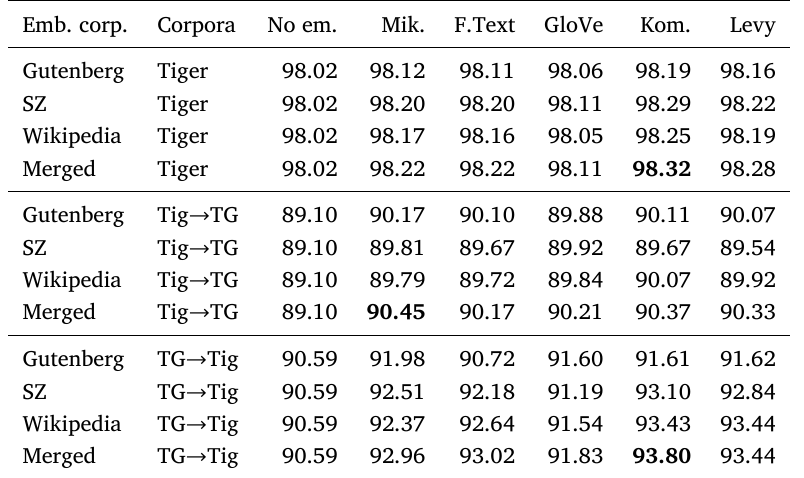
POS (STTS) accuracy in